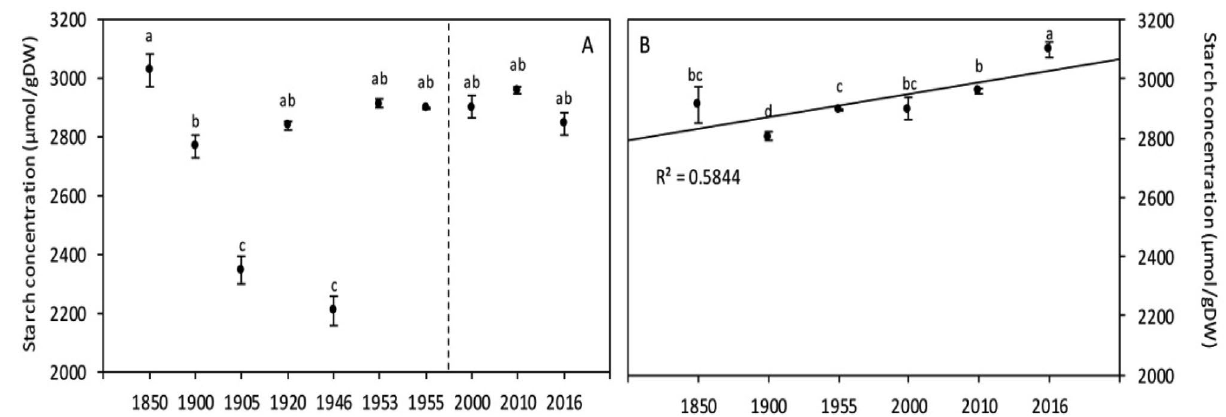
Figure 3. Wheat grain starch content of global ( A ) and Broadbalk experiment ( B ) samples. The dashed line corresponds to the separation between the [1850–1955] and [1965–2016] periods, based on the increase of [CO 2 ]. Data are means ± standard errors (n = 3–14). The same letters indicate no statistically significant differences among years (Fisher’s LSD, p ≥